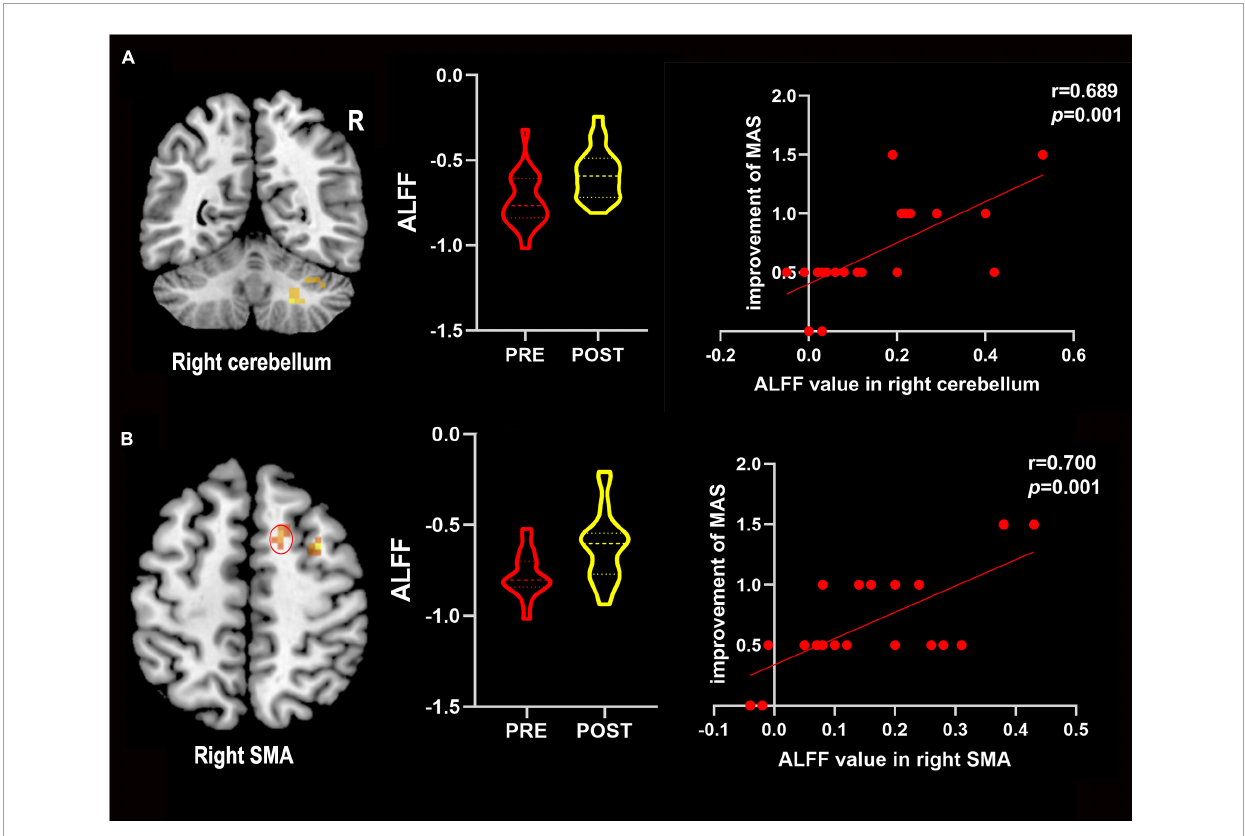
FIGURE4 The change in ALFF values positively correlated with improved MAS scores. (A) Improvements in the MAS score positively correlated with the change in ALFF values in the right cerebellum. (B) Improvements in the MAS score positively correlated with the change in ALFF values in the right SMA. R, right; SMA, supplementary motor area; Pre, pre-treatment in the combined group; Post, post-treatment in the combined